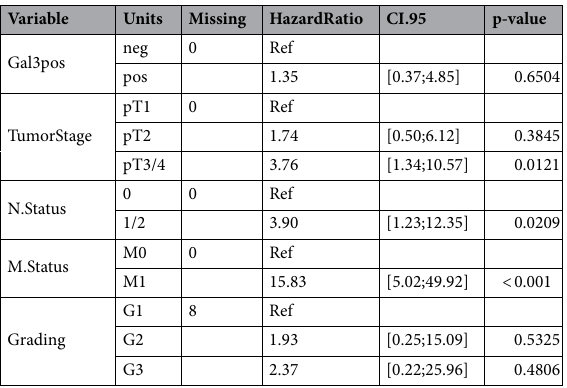
Table 7. Multivariable Cox regression model (n = 111, number of events =